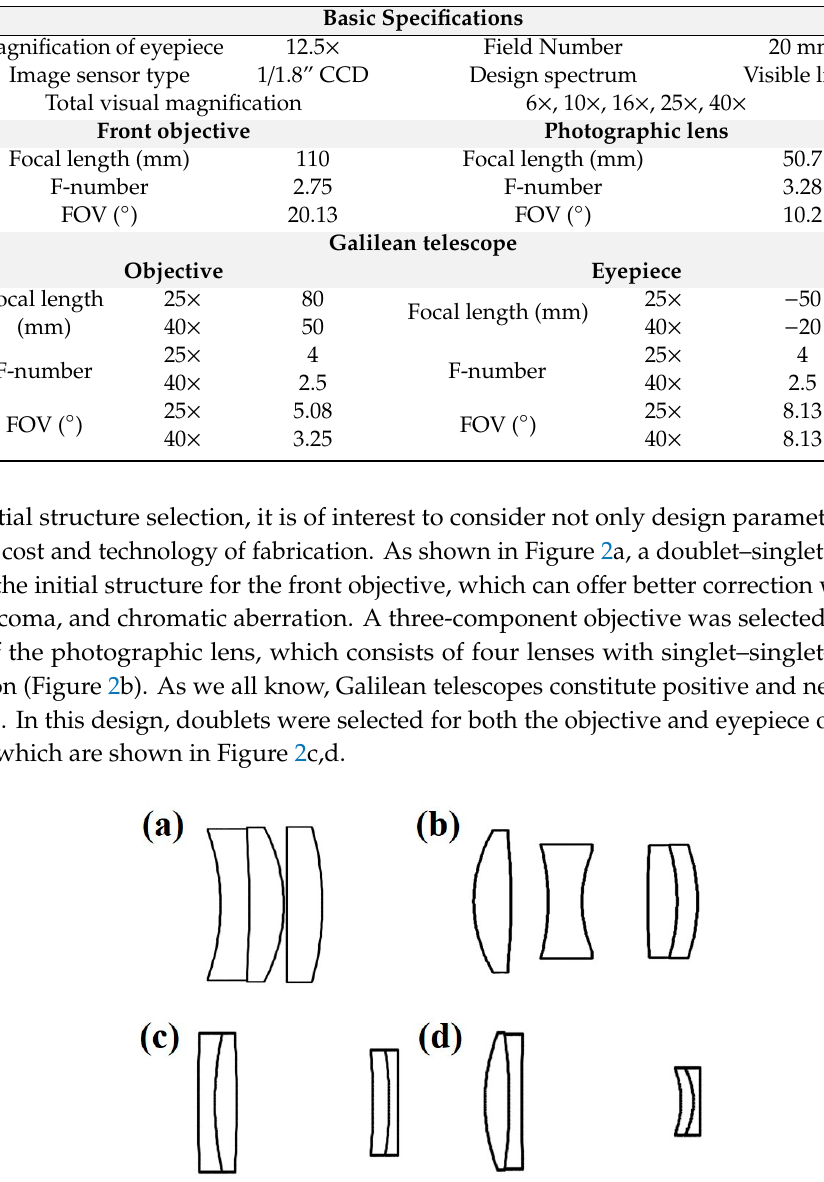
Table 1. Design specifications of the DSLM.